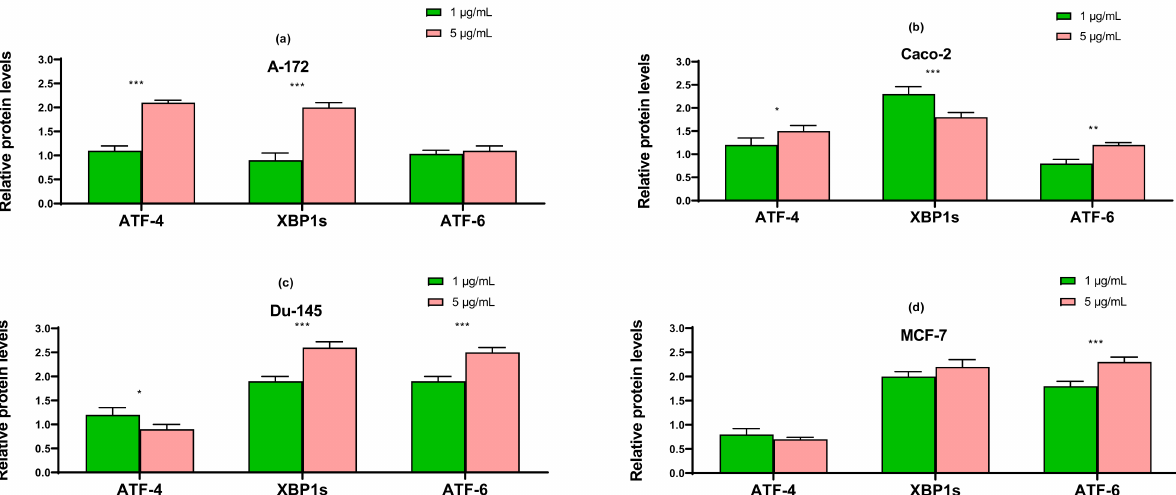
Figure 7. Western blot analysis of ER stress response key markers in various cancer cells ( a )—A-172; ( b )—Caco-2; ( c )—Du- 145; ( d )—MCF-7 after 1 and 5 µ g/mL SeNP treatment for 24 h. Data are expressed as percentage of control (intact cells; set to 100). Each value is the mean ± SD ( n ≥ 3, p < 0.05; t -test). Two-way ANOVA with Sidak’s multiple comparisons test. Comparison 1 µ g/mL and 5 µ g/mL, *** p -level < 0.001, ** p -level < 0.01, * p -level < 0.05.